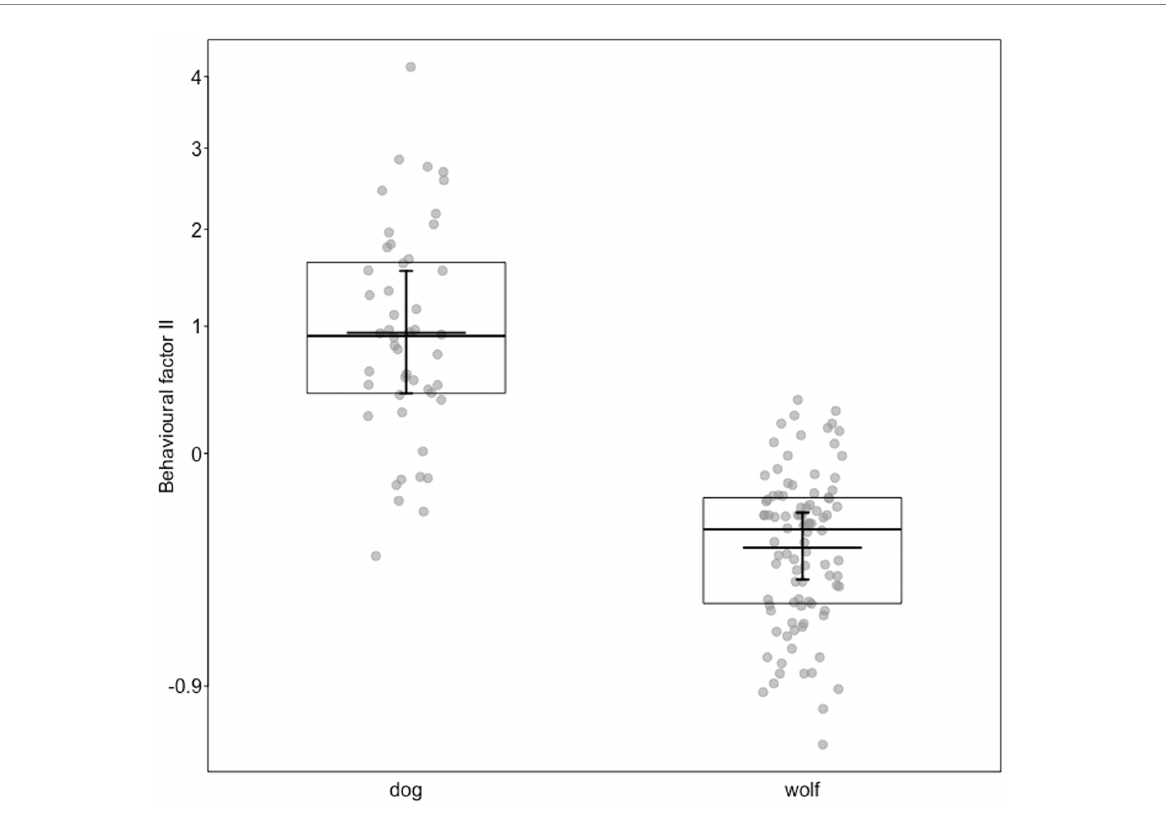
FIGURE 3 Behavioral factor II ( y -axis), separately for dogs and wolves. Dots show the individual data, horizontal lines with boxes medians and quartiles, and the short horizontal lines with error bars the fitted model and its 95% confidence limits with all other predictors centered to a mean of zero. Behavioral factor II was mainly correlated with proportion time tail wagging, proportion time licking trainer’s hand or face, and numbers of lips